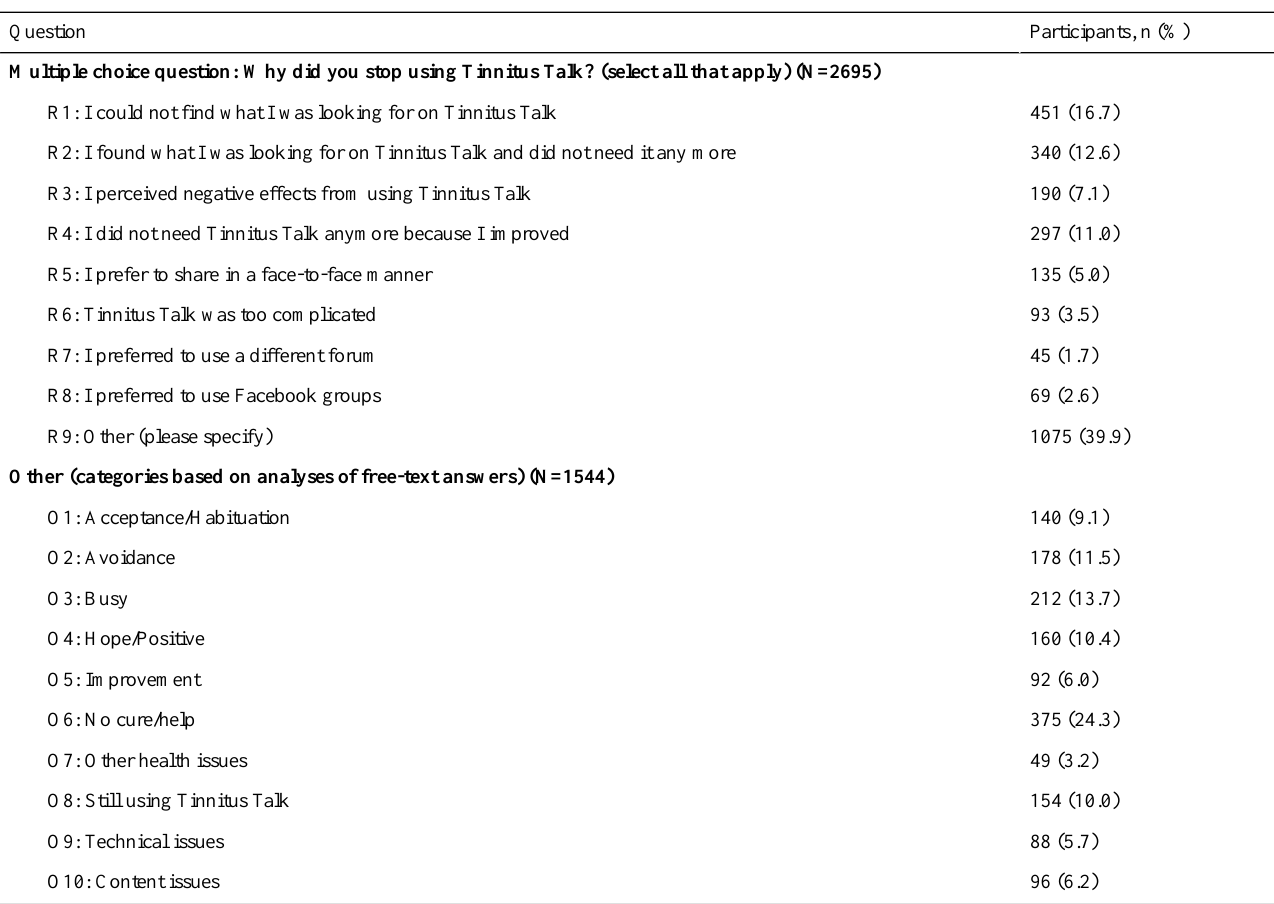
Table 2. Users’reasons for discontinuing the use of Tinnitus Talk.